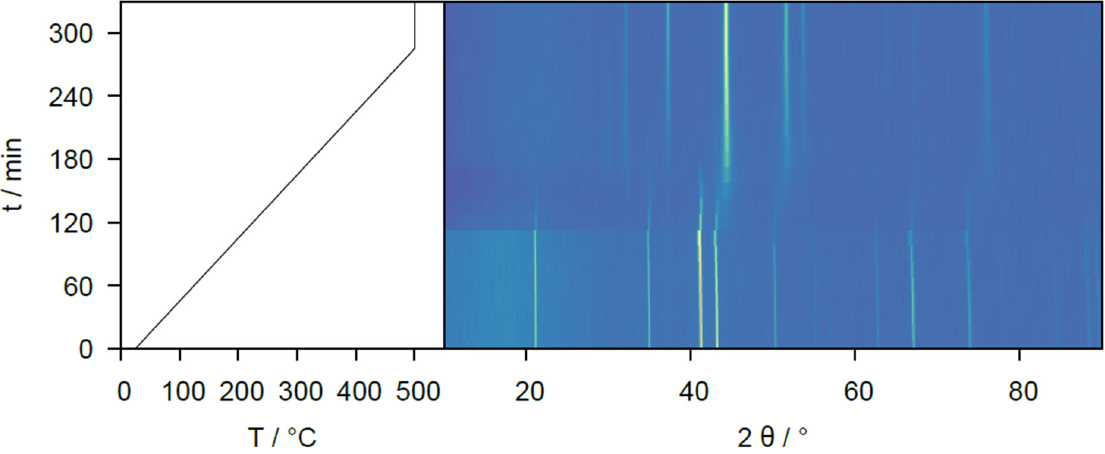
Figure 4. In situ X-ray powder diffraction of CaNi 2 .